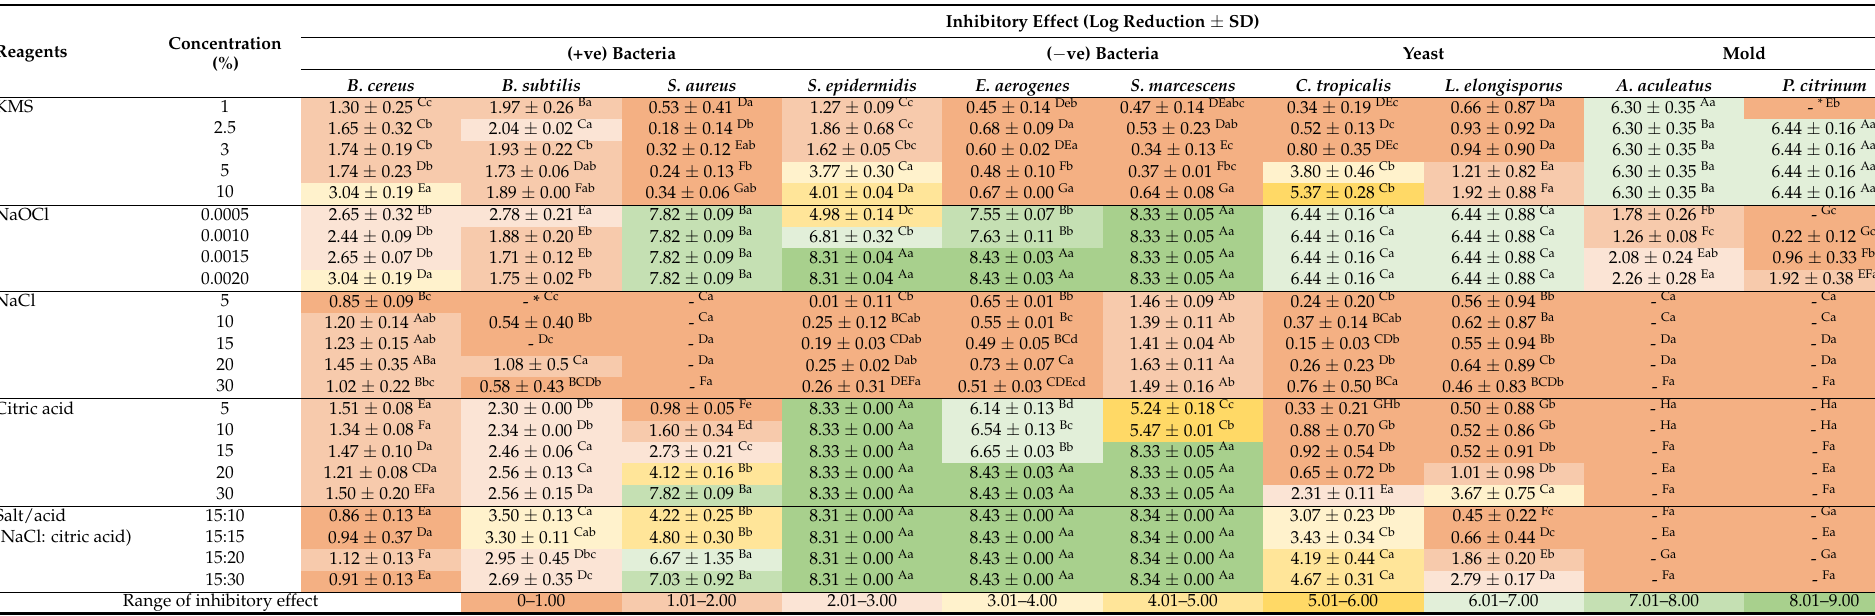
Table 1. Antimicrobial reagent concentrations on Bacillus cereus , Bacillus subtilis , Staphylococcus aureus , Staphylococcus epidermidis , Enterobacter aerogenes , Serratia marcescens , Candida tropicalis , Lodderromyces elongisporus , Aspergillus aculeatus and Penicillium citrinum during contact time of 10